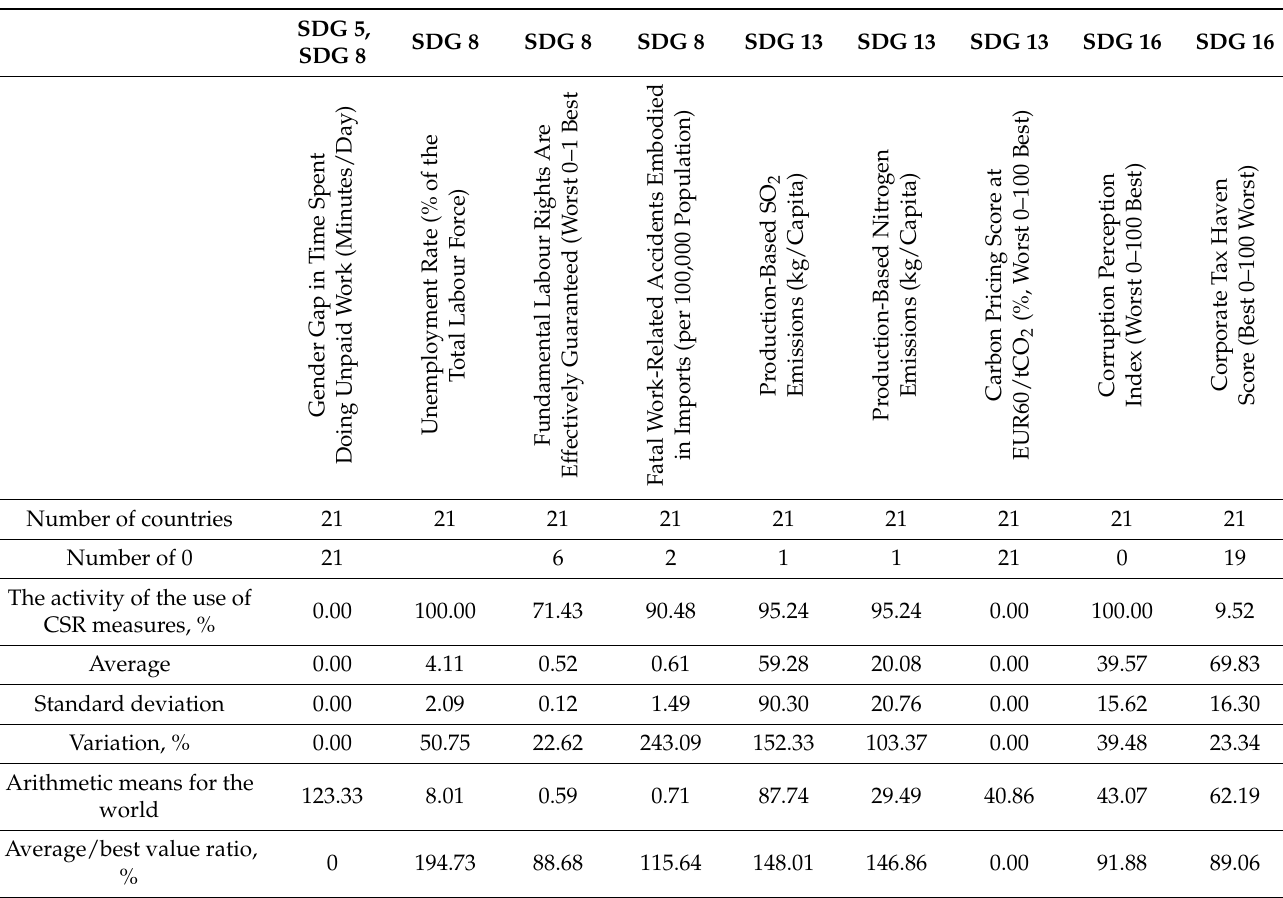
Table 6. Representation of the CSR practices to support the SDGs (UN standards) in countries of East and South Asia in